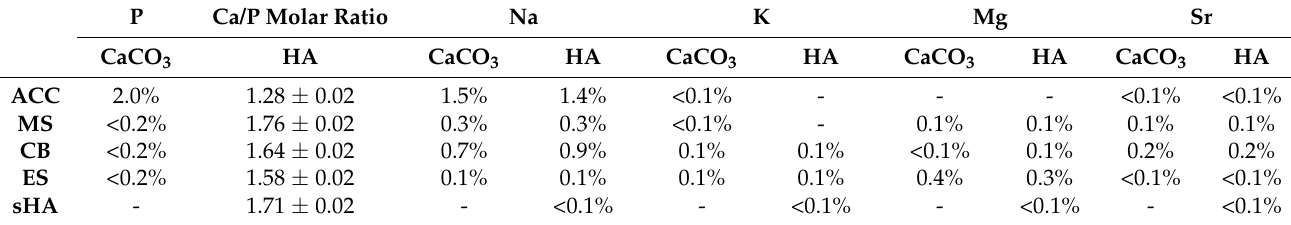
Table 3. The concentration of the fundamental elements and Ca/P molar ratio in the raw materials (CaCO 3 ) and synthesized powders (HA) as determined by inductively coupled plasma/optical emission spectroscopy (ICP/OES) analysis.